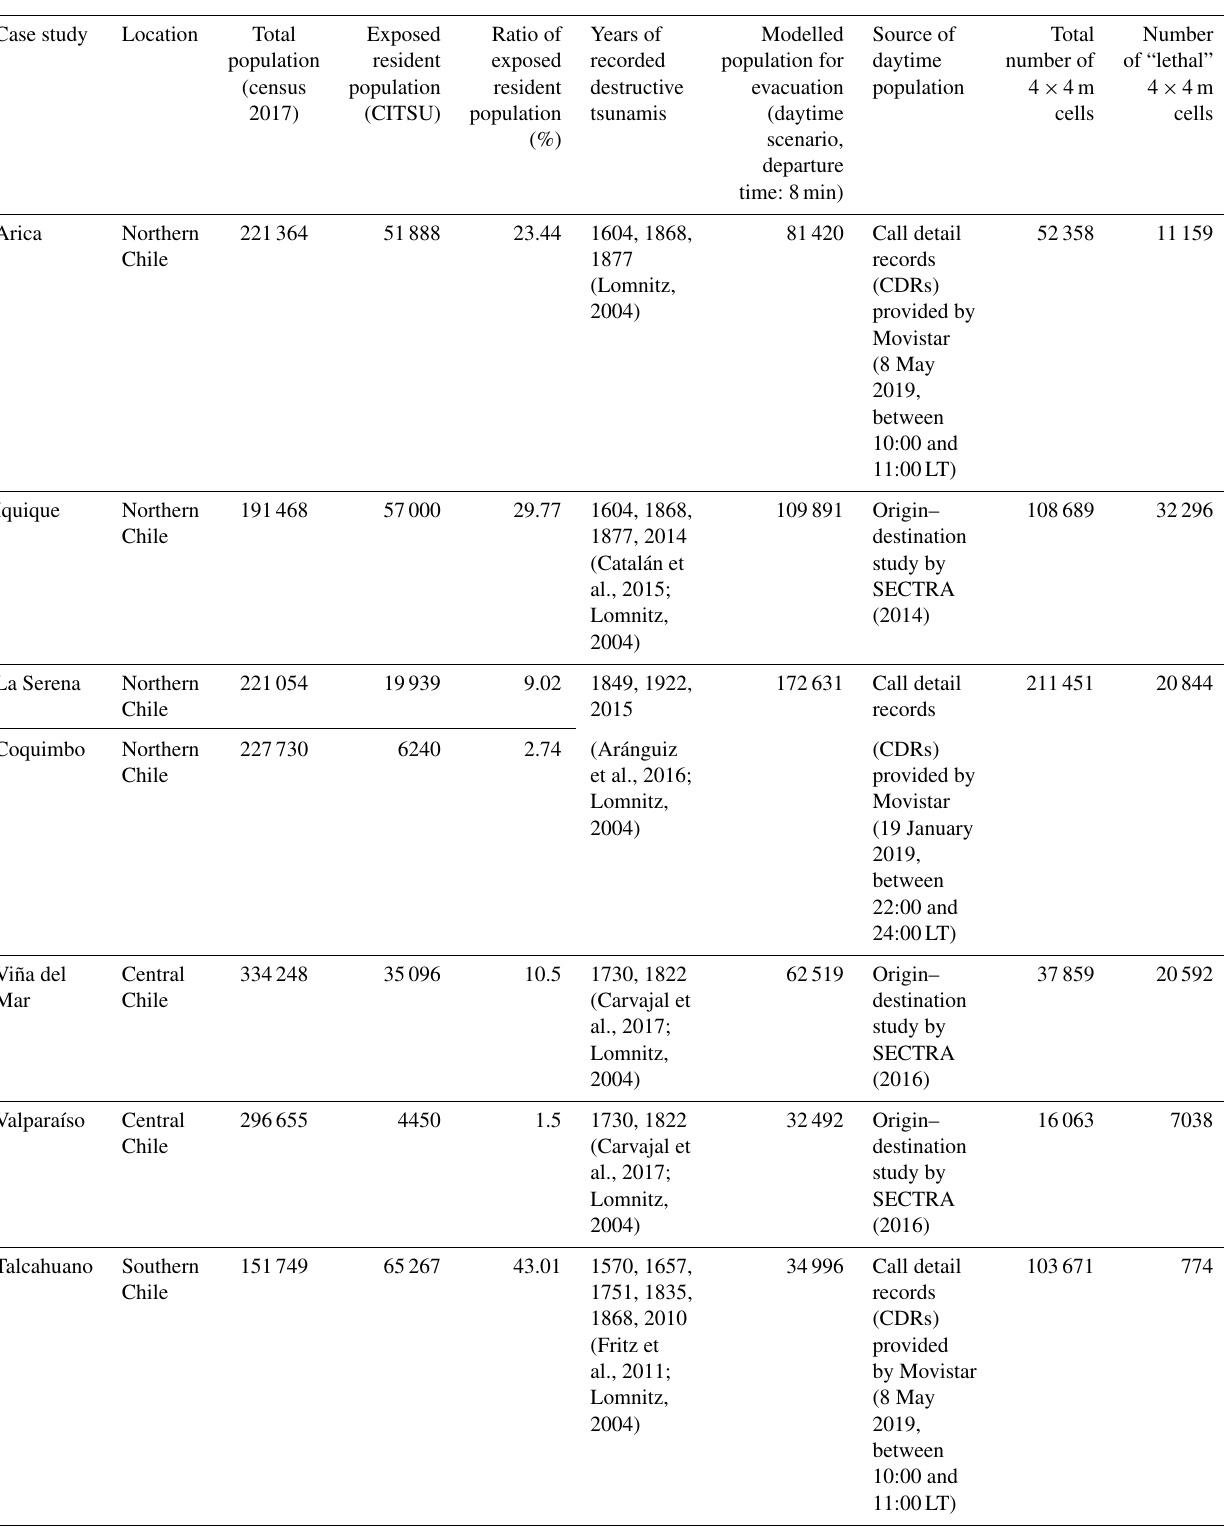
Table 1. Attributes of the examined case studies in Chile. CITSU: Carta de Inundación por Tsunami. SECTRA: Programa de Vialidad y Transporte